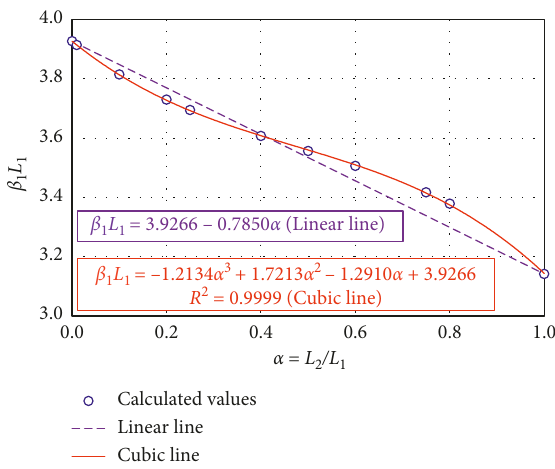
Figure 9: Relationships between β trendlines for α